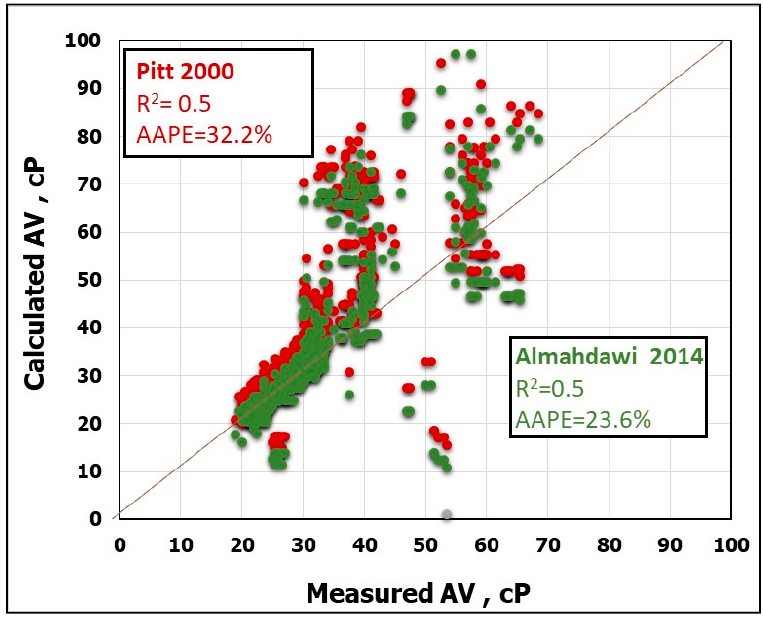
Figure 8. Prediction of 𝐴𝑉 using Pitt's [17] and Almahdawi’s et al. [18] correlations .